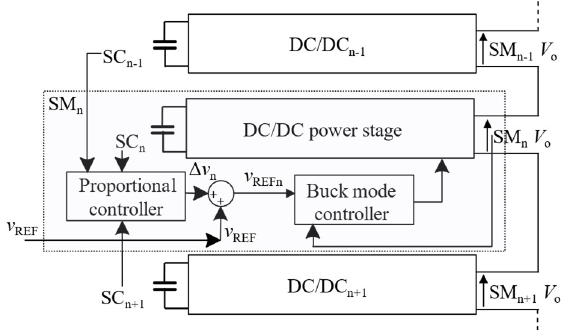
Figure 9. Balancing control integrated in each SM to achieve self-balancing.